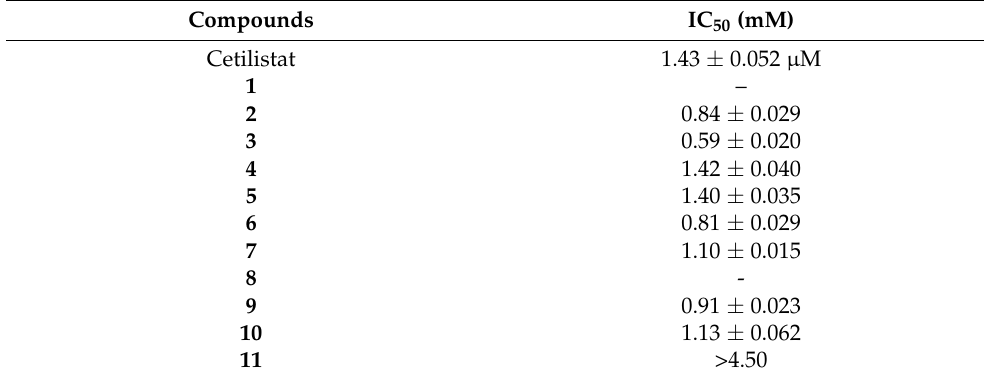
Table 4. The pancreatic lipase inhibitory activity of 1 – 11 .